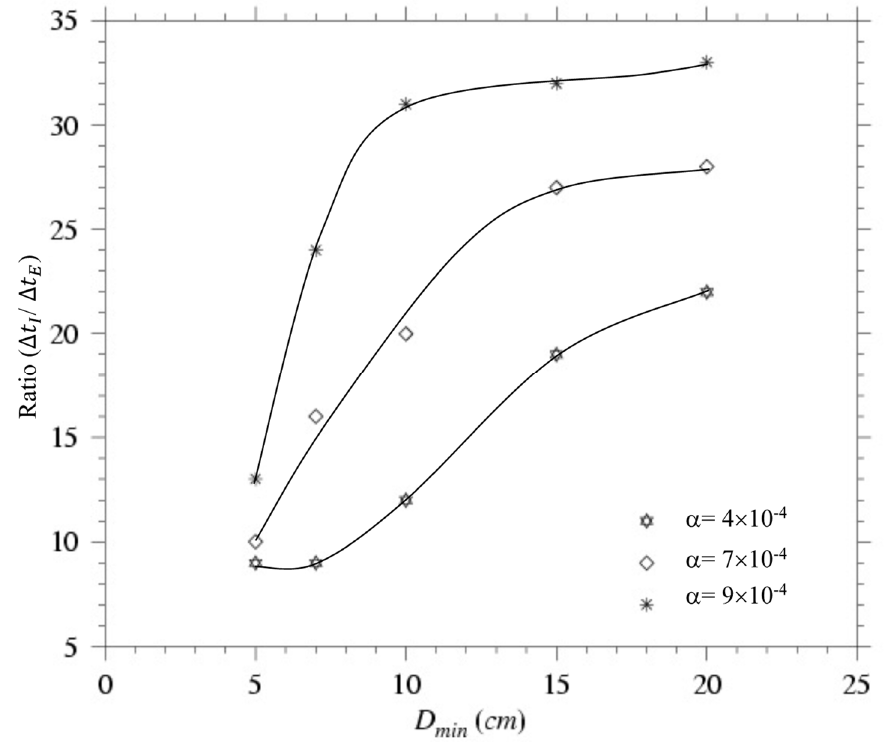
Figure 8. The model-derived relationship of ∆𝑡 (cid:3010) / ∆𝑡 (cid:3006) with the thickness of the viscous bottom layer ( D min ) for the three cases with α = 4.0 × 10 − 4 , 7.0 × 10 − 4 and 9.0 × 10 − 4 . In the three cases, ∆𝑡 (cid:3006) = 4.14 s, kb = 6, and 𝜁 (cid:3042) = 1.5 m.